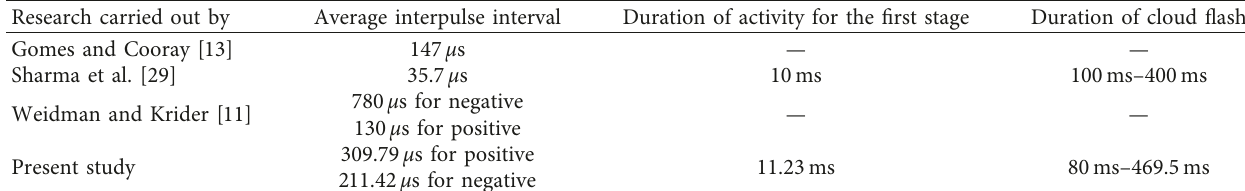
Table 5: A comparative presentation of the features of cloud flashes from various geographical locations. Research carried out